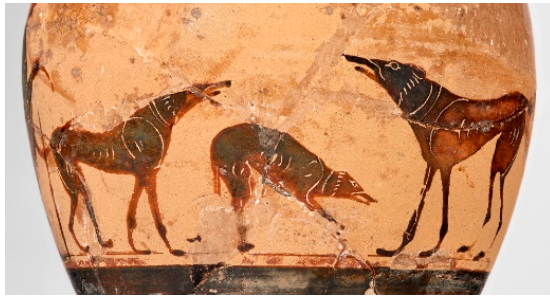
Figure 11. Detail of Figure 9.